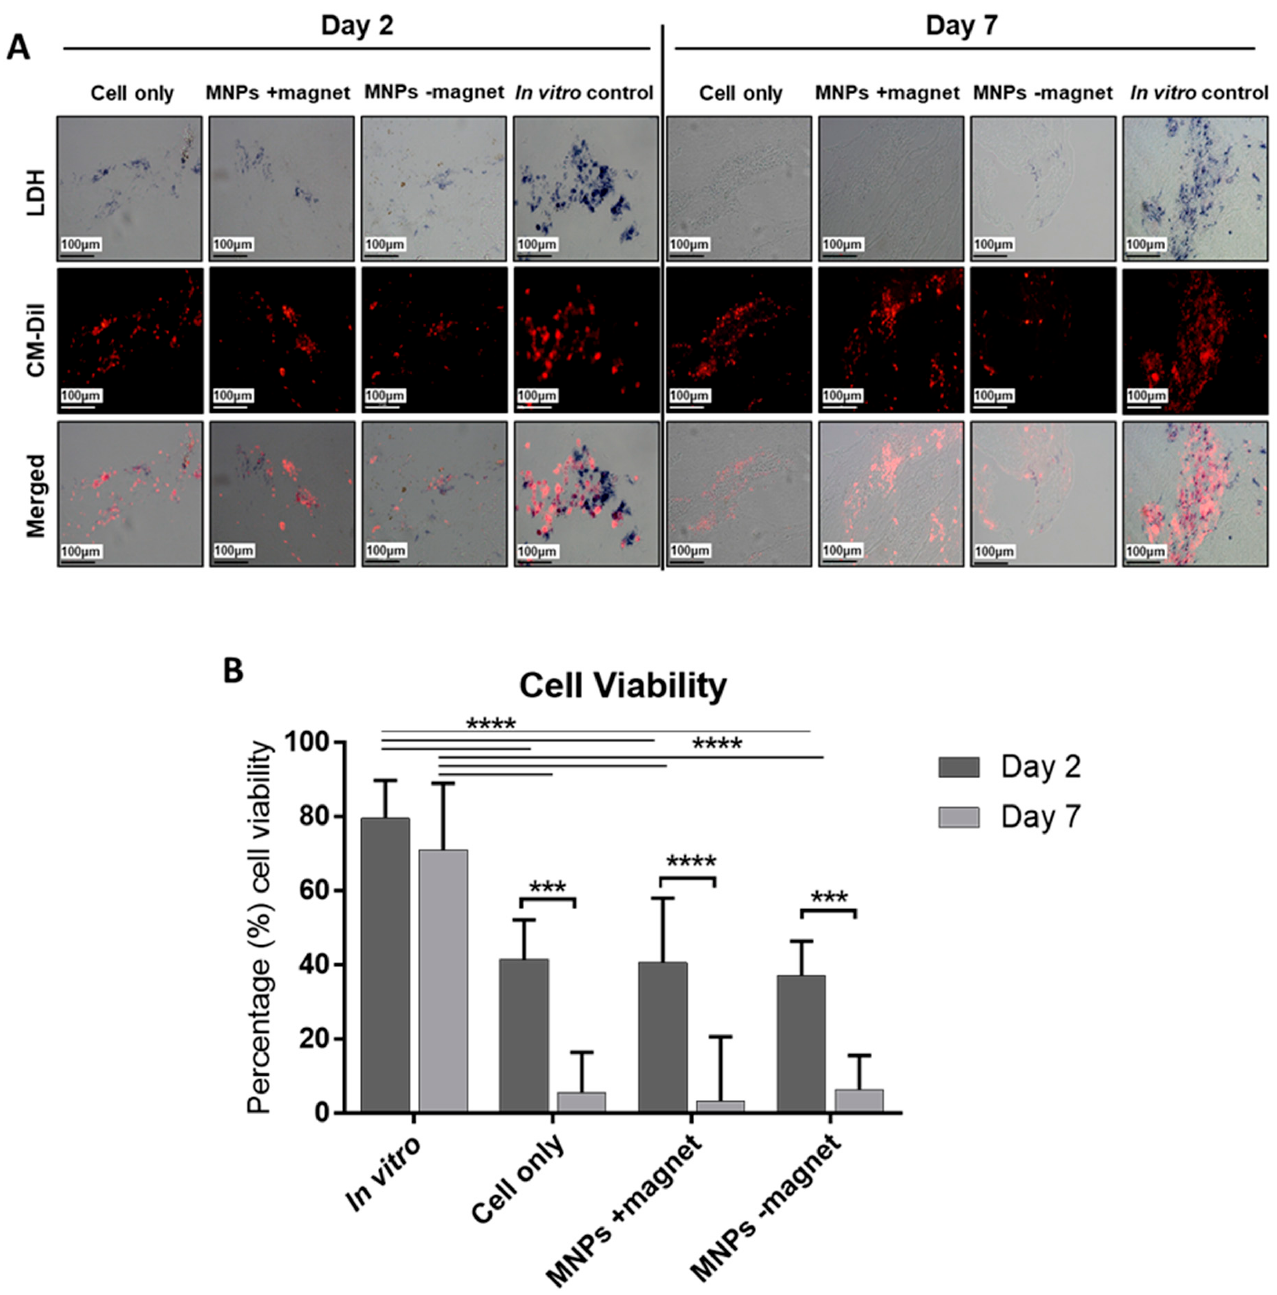
Figure 2. Assessment of oMSC viability at 2 and 7 days post-implantation. ( A ) LDH-stained cryo-sectioned samples of the extracted in vivo construct and time point-matched in vitro controls. Blue staining is indicative of viable oMSCs as determined by the LDH reaction, while red fluorescent staining identifies the CM-Dil-positive implanted oMSCs. The viability of implanted cells was determined by the co-localisation of blue and red fluorescent stains. ( B ) Quantification of cellular viability for all in vivo groups (cells, MNPs +magnet, MNPs − magnet) was undertaken and compared to time point-matched in vitro controls. Data are presented as the average viability (proportion of duel LDH:CM-Dil-labelled cells relative to total CM-Dil-labelled cells) for five random areas per section. Significance was determined by a two-way ANOVA statistical test, where *** is p < 0.001 and **** is p < 0.0001. Scale bar =100 µ